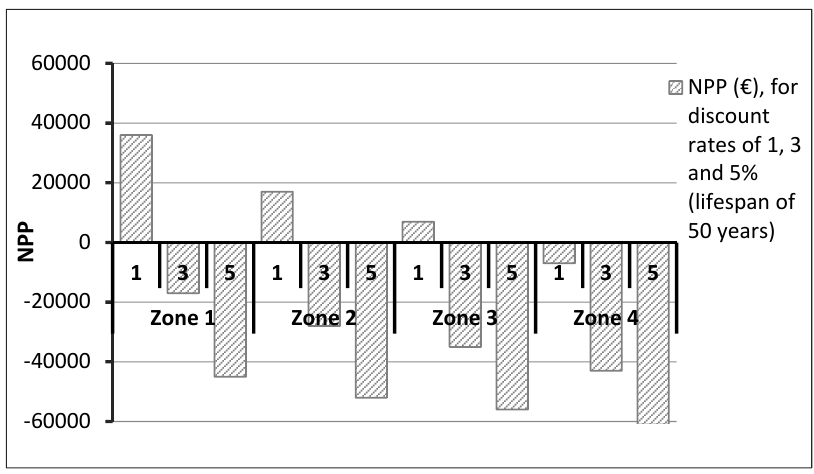
Figure 17. The cost ‐ effectiveness of basement wall energy renovation, corresponding to the optimum measures.